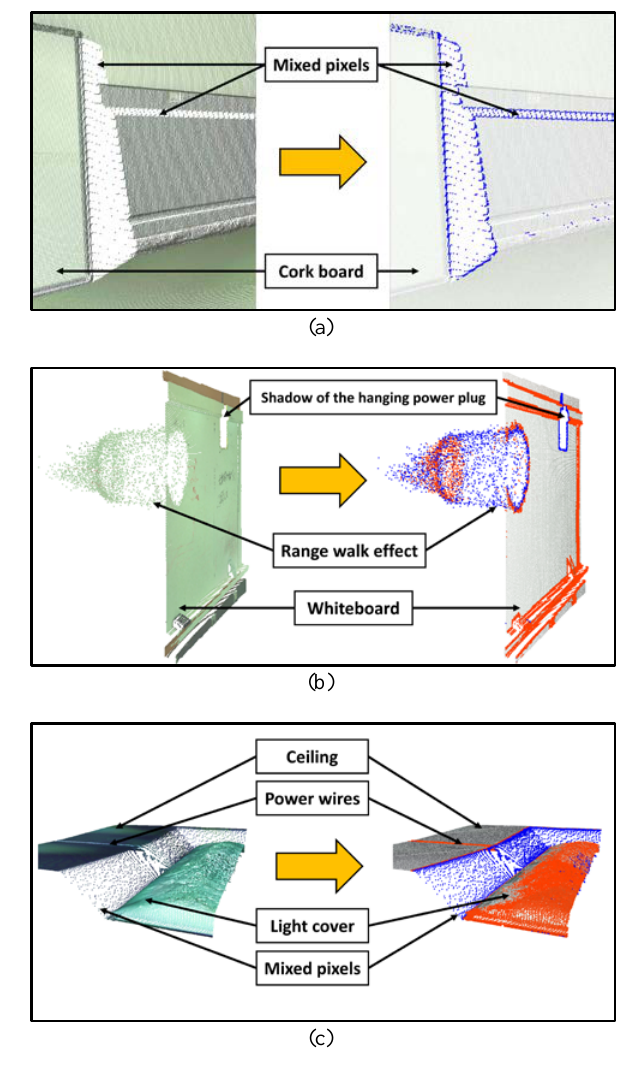
Figure 4. The proposed edge detection approach separates the points with different types of noise from the ones on the smooth surface: (a) mixed pixels; (b) range walk; (c)